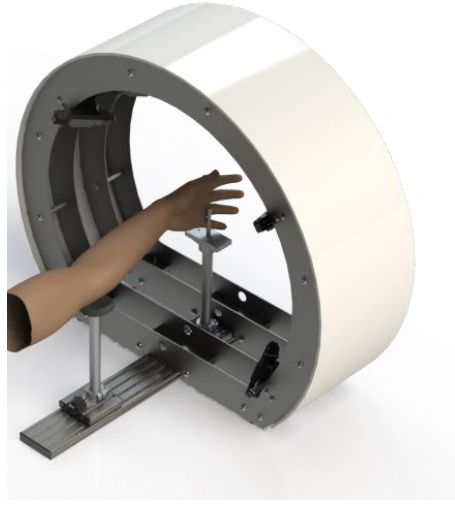
Figure 10 . “Oplà” 3D scanner v ersion 1 Figure 10. “Opl à ” 3D scanner version